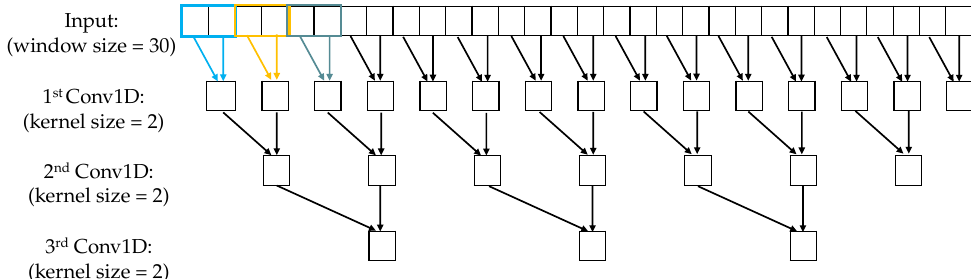
Figure 5. Short-scale module, window size = 30, strides = 2, kernel size = 2, no zero